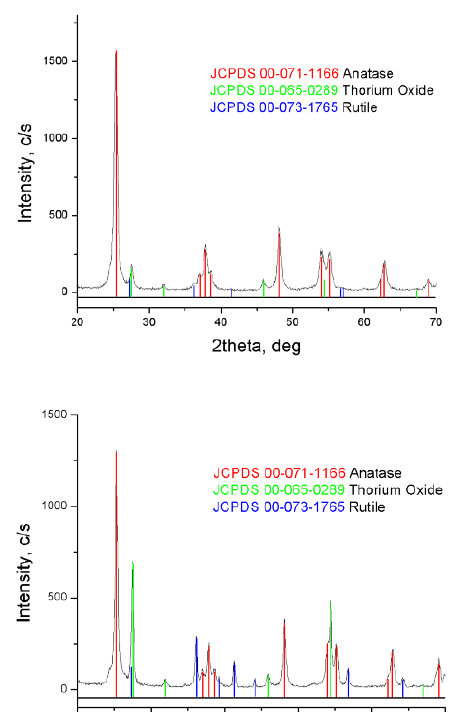
(1), TiO containing 1% (2) and 2% (3) ThO 2 2